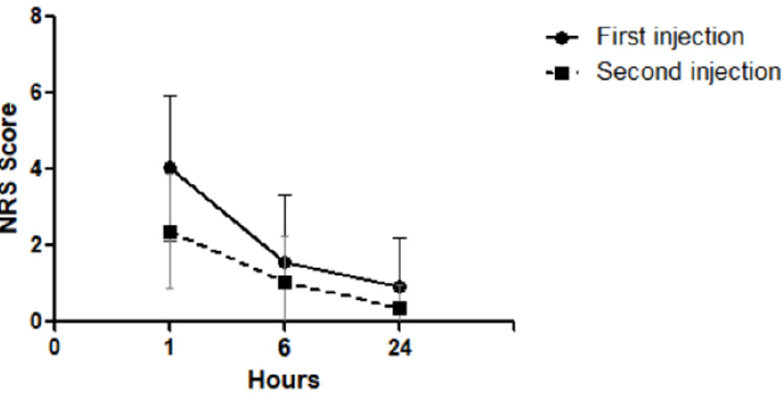
Figure 1. Change in post-injection pain scores after first and second injection